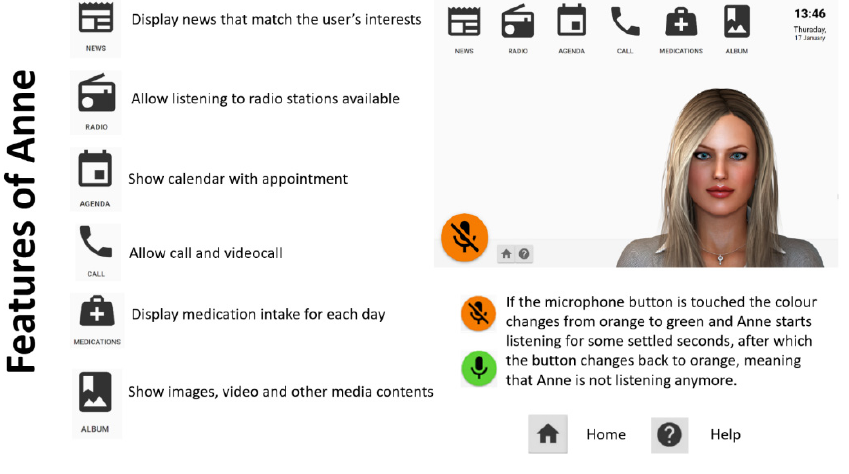
Figure 1. The ECA Anne.